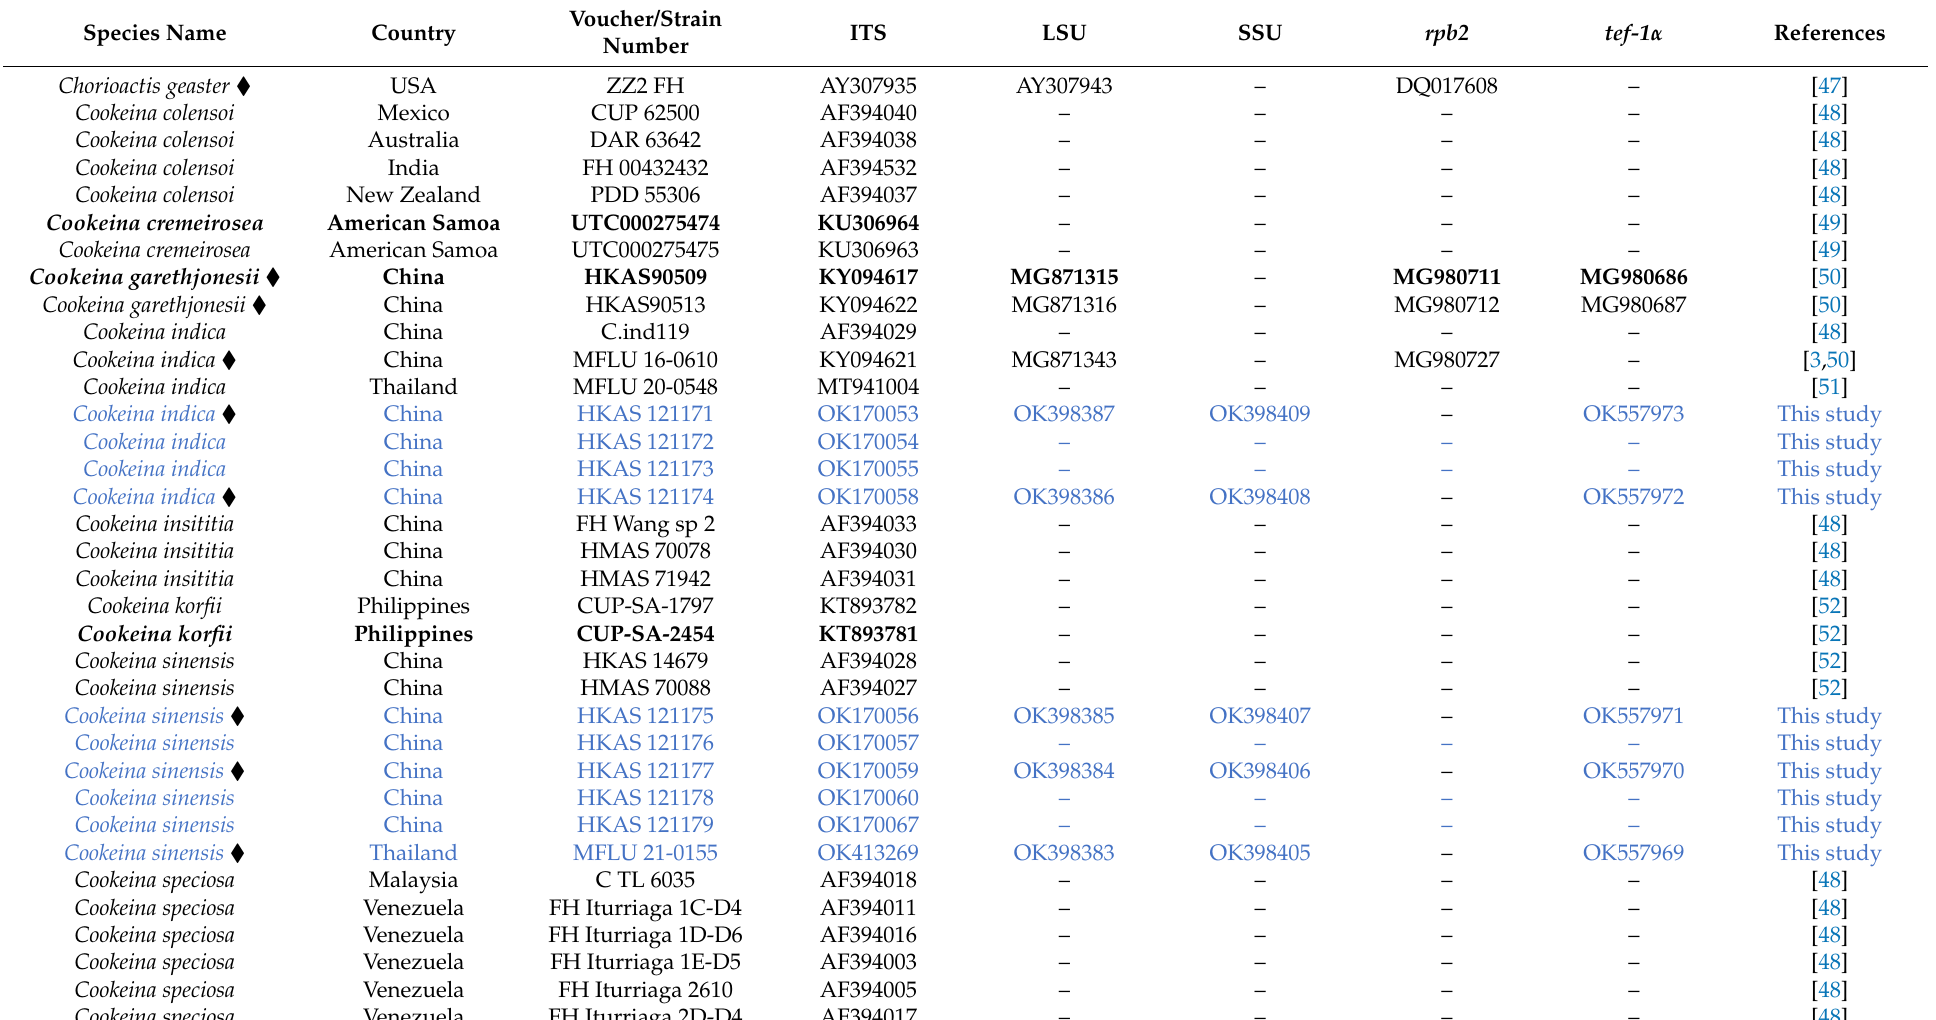
Table 1. Sequences used in this